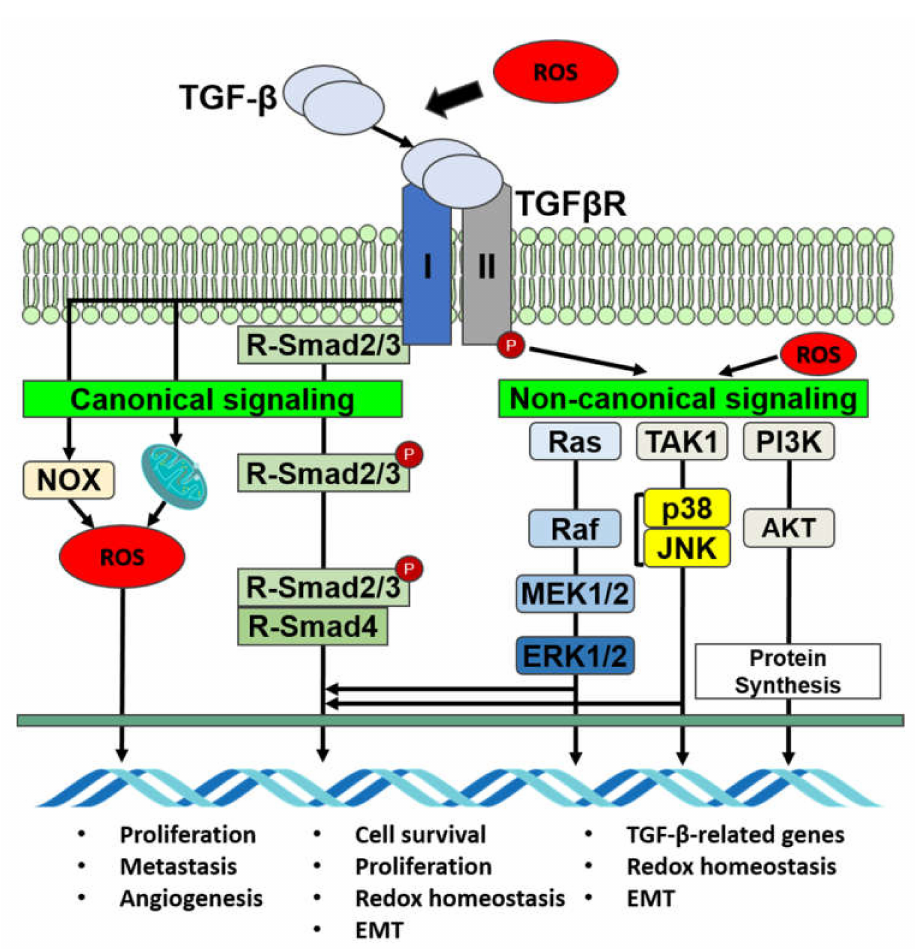
Figure 3. Signaling of TGF- β and oxidative stress in cancer